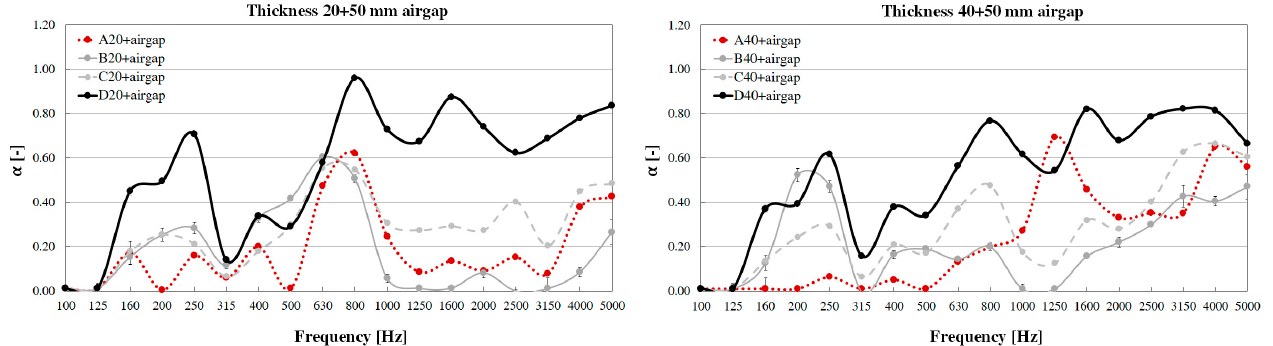
Figure A2. Comparison of the absorption coefficients for samples A–D with different thicknesses obtained from multiple layer combinations (20 + 20 and 20 + 40 mm). Sample A: crushed normal weight aggregates 4–8 mm; Sample B: round lightweight aggregates 4–8 mm; Sample C: round lightweight aggregates 2–4 mm; Sample D: round lightweight aggregates 0.5–1 mm.